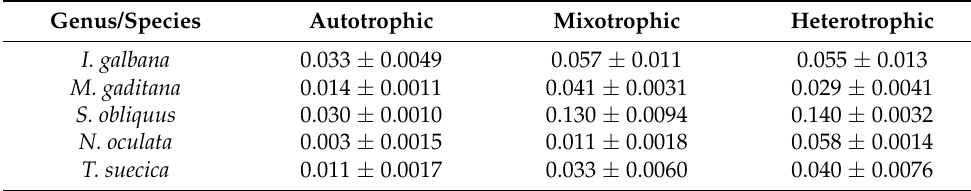
Figure 1. Algal biomass growth achieved using ( a ) autotrophic, ( b ) mixotrophic and ( c ) heterotrophic nutrition. Error bars represent mean values ± standard deviation (n = 6). Table 2. Biomass productivity (g L − 1 d − 1 ) of the five microalgae species investigated. Values represent mean values ± standard deviation ( n =